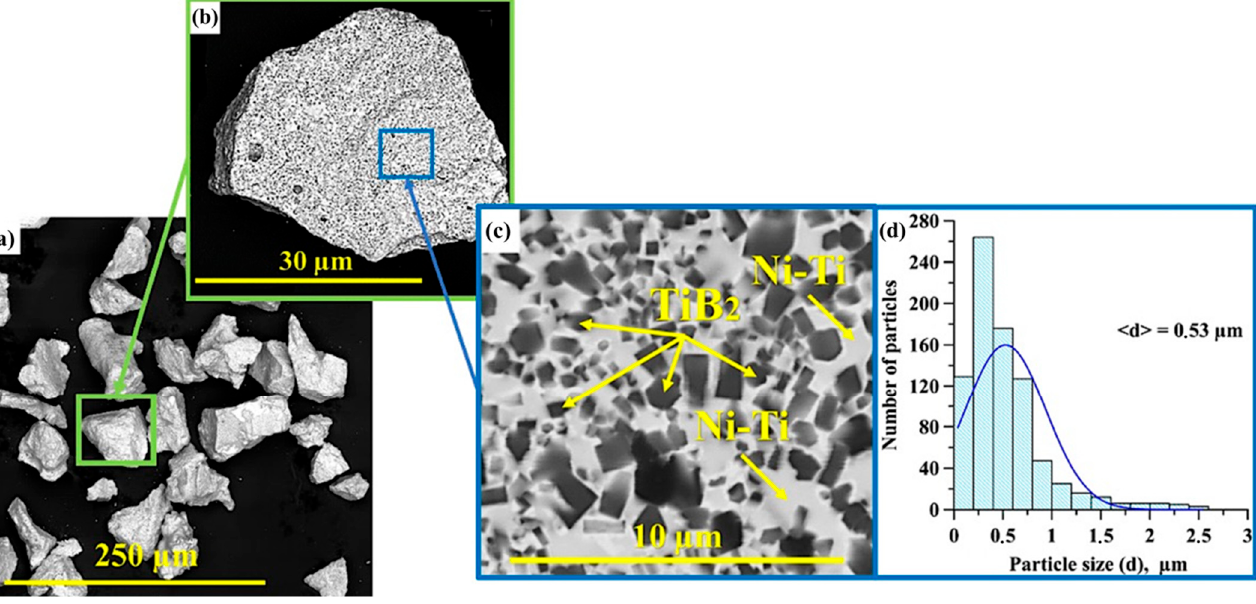
Figure 1. SEM image of NiTi-TiB2 SHS particles ( a , b ), SEM image of their structure ( c ) and a histogram of the distribution of TiB2 inclusions by size ( d ).